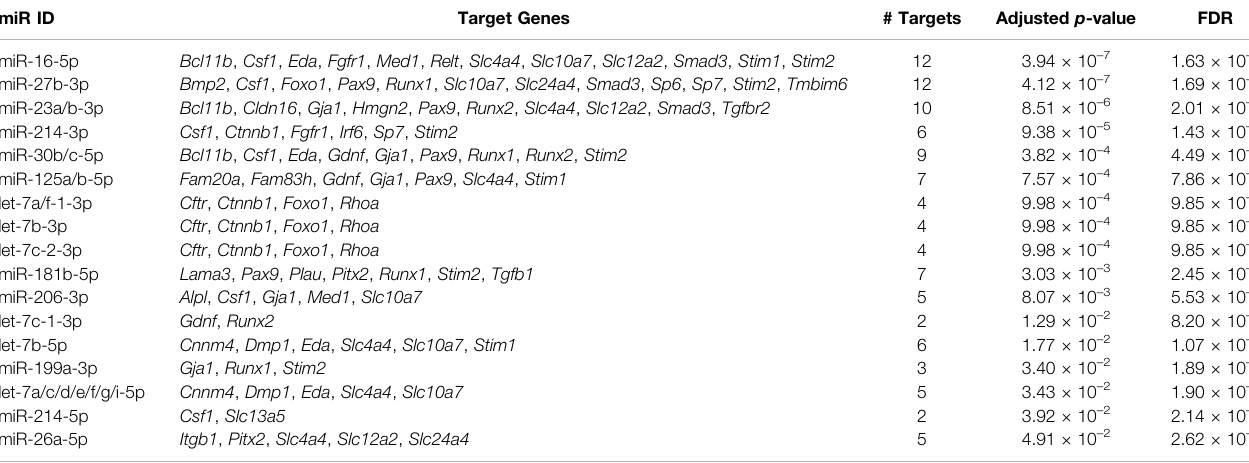
TABLE 6 | MicroRNA (miRNA) enrichment analysis of mouse genes related to amelogenesis imperfecta. miR ID Target